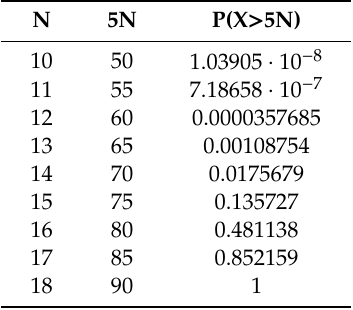
Table 2. Number of customers = 20N (k = 20).